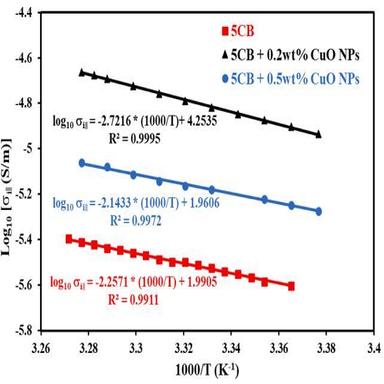
Variation of the ionic conductivity (σi‖) with the inverse of absolute temperature in the nematic phase (homeotropic alignment). Curves for pure 5CB (squares), 5CB + 0.2 wt% CuO NPs (triangles) and 5CB + 0.5 wt% CuO NPs (Circles).